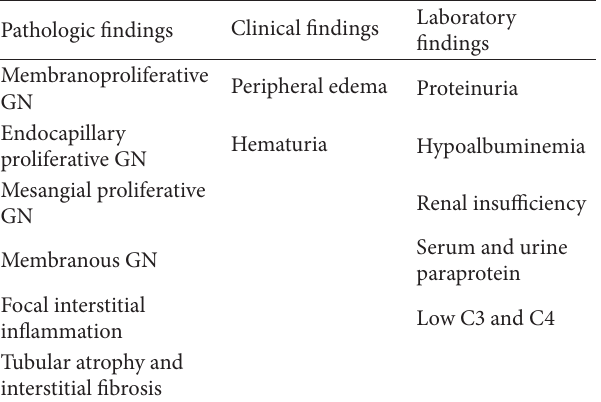
Table 1: Clinical manifestations of PGNMID